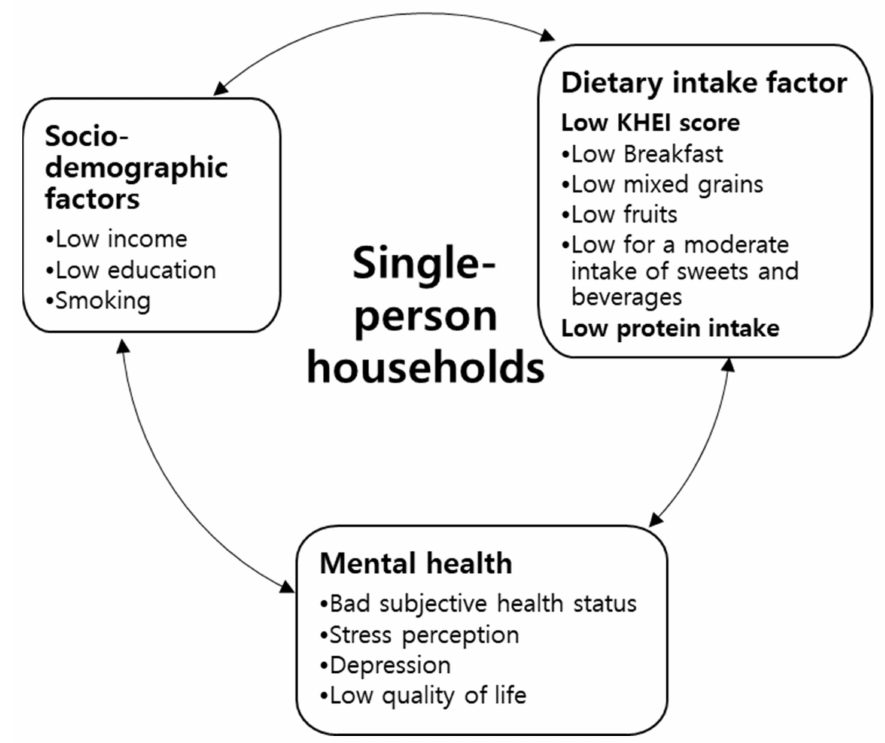
Figure 1. Key findings between dietary factor s and mental health in single-person